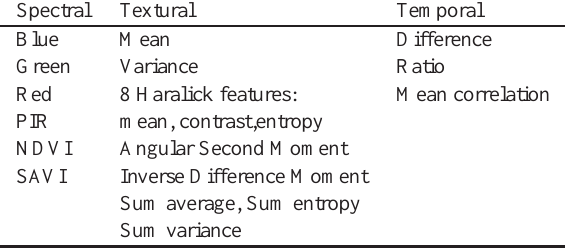
Table 1: Input features